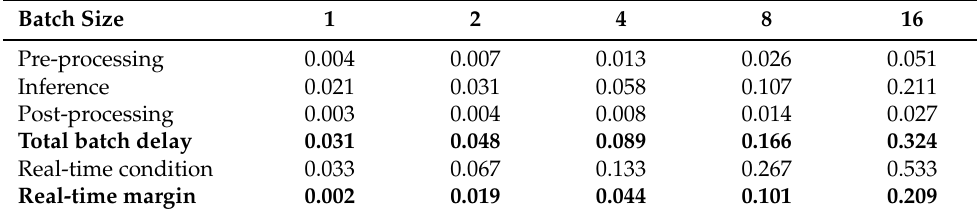
Table 1. Delays and real-time constraints on a Xavier.